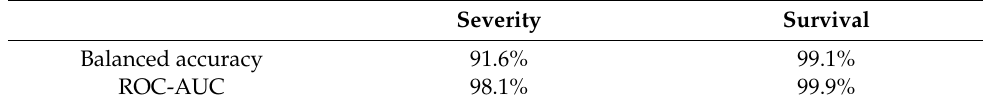
Figure 3. ROC curve on test set for COVID-19 survival prediction model. Table 1. Evaluation metrics for COVID-19 severity and survival models.